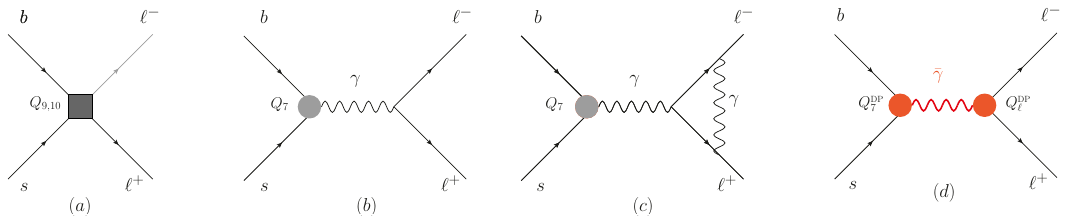
Figure 1 . Feynman diagrams for the b quark decay b ! s‘ + ‘ (cid:0) : (a){(c) represent the SM contri- bution including vertex radiative corrections in the (cid:12)nal leptons (c), while diagram (d) corresponds to the exchange of a massless dark-photon, mediated by magnetic-dipole interactions. The gray square and circular vertices represent the insertion of the 4-fermions Q 9 ; 10 and magnetic-dipole Q 7 operators respectively, while the red circular vertex represent the insertion of the magnetic-dipole operators with a dark photon, namely Q DP dark-photon (cid:12)eld